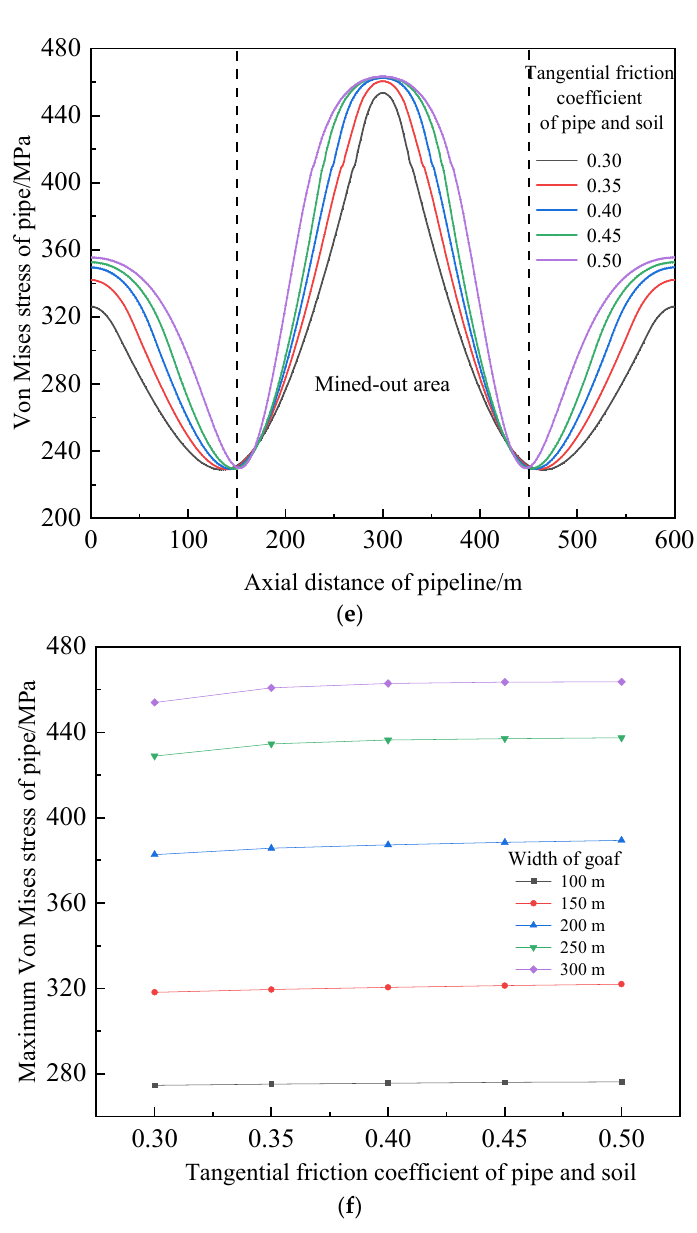
Figure 8. Von Mises stress curves of the pipe with different tangential friction coefficients. ( a ) Goaf width of 100 m. ( b ) Goaf width of 150 m. ( c ) Goaf width of 200 m. ( d ) Goaf width of 250 m. ( e ) Goaf width of 300 m. ( f ) Maximum von Mises stress of the pipe.